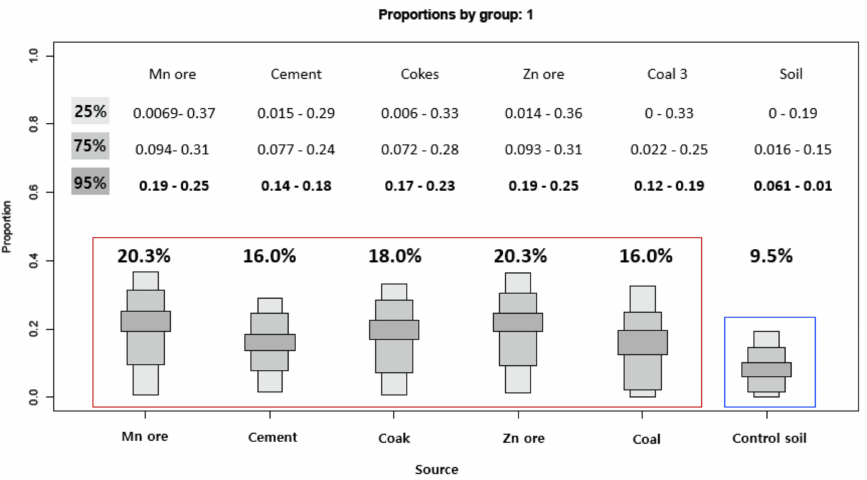
Figure 5. Average contribution of the different sources determined by Iso-source R to the soil and urban dust